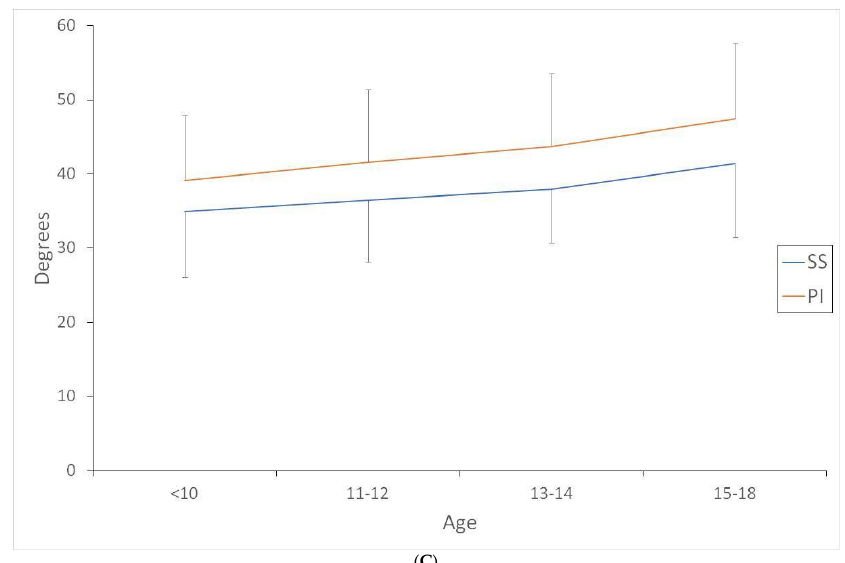
Figure 2. Variation with the age of ( A ) Sacral Slope (SS) and ( B ) Pelvic Incidence (PI), and ( C ) dif- ferences between age groups. While correlations for SS and PI with age were low (0.182 and 0.236, respectively), the differences between age groups appeared statistically significant for SS after age 14 and for PI after age 10.